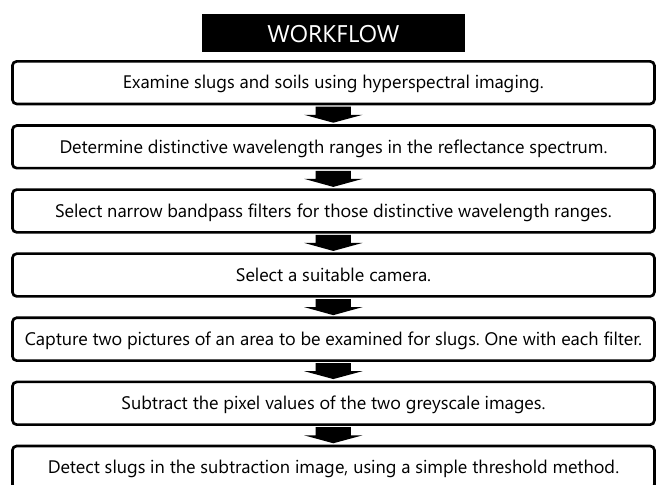
Examine slugs and soils using hyperspectral imaging.